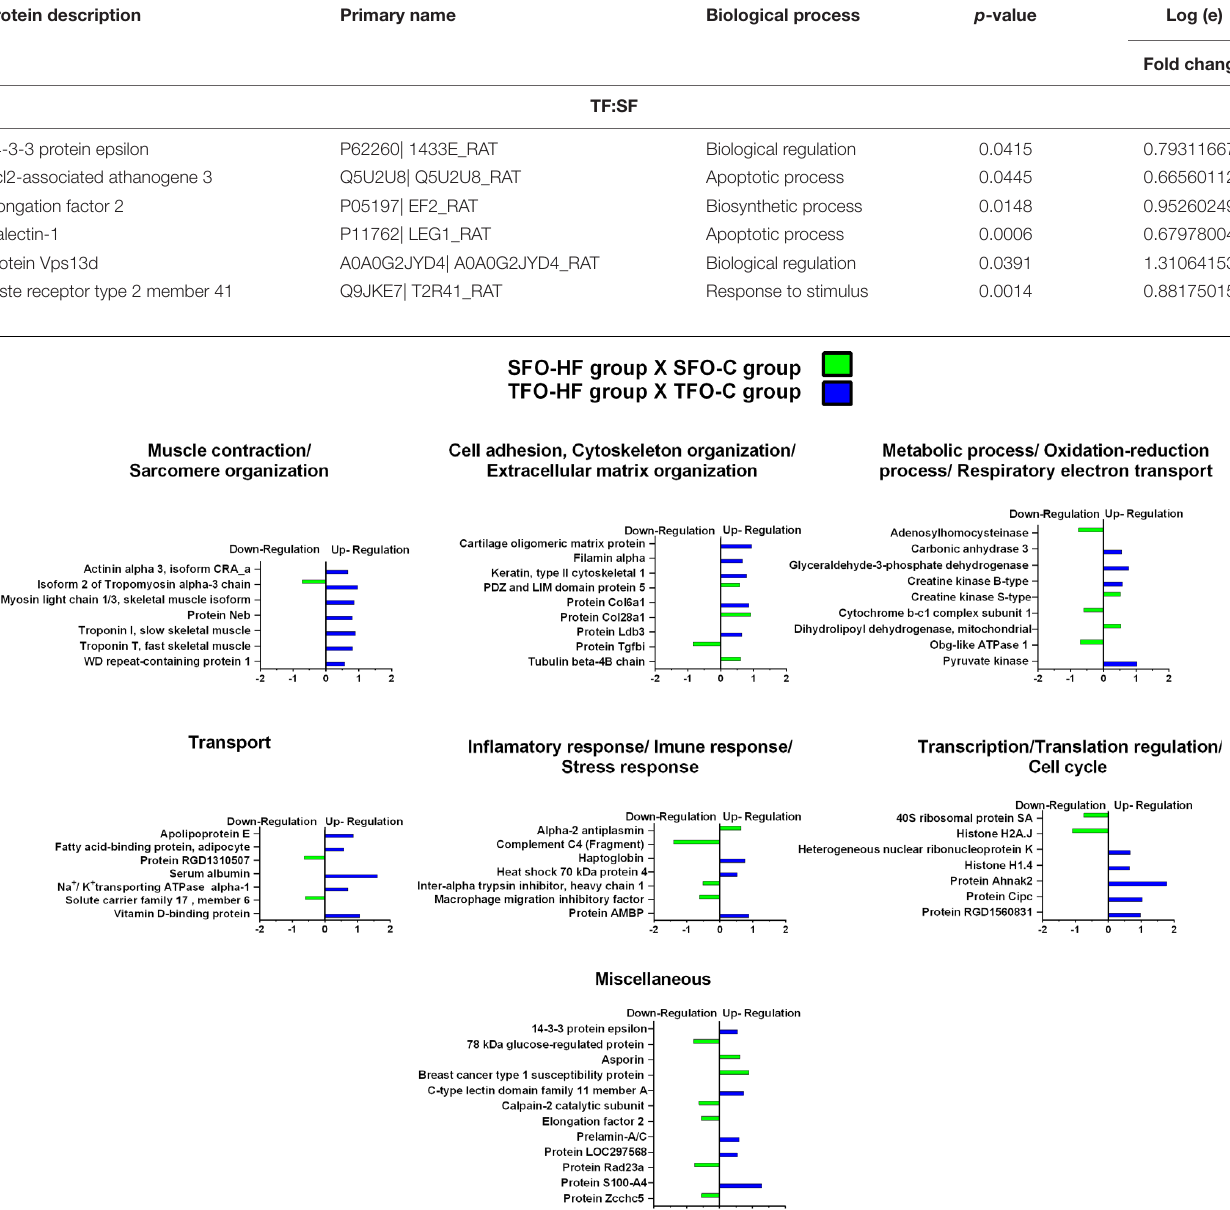
TABLE 2 | Protein abundance levels related to miscellaneous functions from TF:SF analysis considering only proteins with up-regulation and down-regulation ( p ≤ 0.05) with a delta ( (cid:49) ) of at least ( ≥ ) 0.5-fold change. Protein description